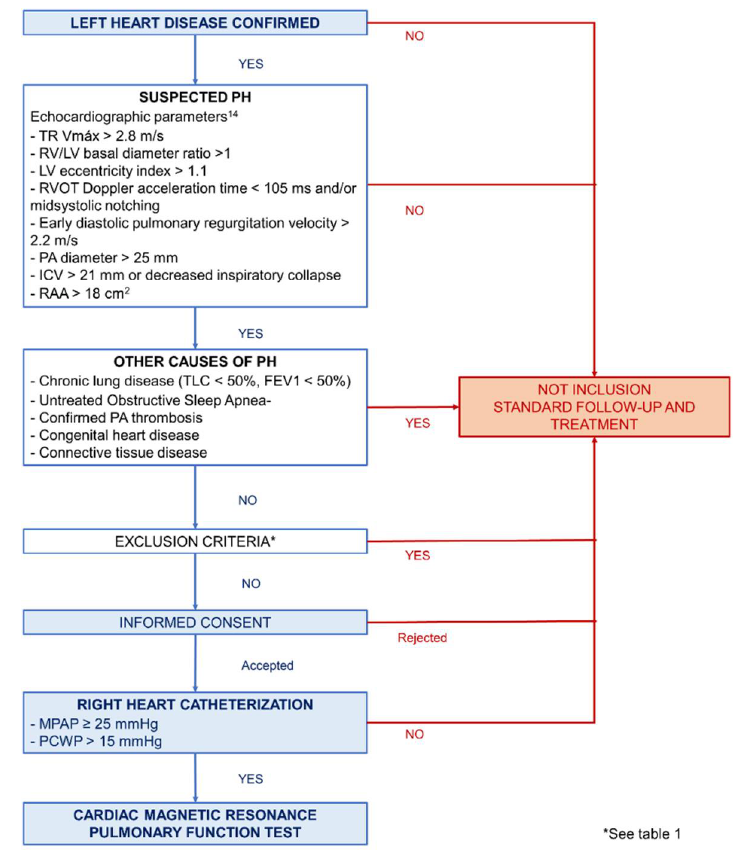
Figure 2. Patients’ selection and study organization. Patients with symptomatic HF will be considered for the study if they have been diagnosed with left heart disease with an echocardiographic suspicion of PH, not explained by other causes. Those patients meeting all inclusion criteria and no exclusion criteria (see Table 1) who have PH confirmed by RHC will be submitted to magnetic resonance imaging and a pulmonary function test. ICV: inferior cava vein; LV: left ventricle; MPAP: mean pulmonary artery pressure; PA: pulmonary artery; PCWP: pulmonary capillary wedge pressure; PH: pulmonary hypertension; RAA: right atrial area; RV: right ventricle; RVOT: right ventricle outflow tract; TLC: total lung capacity; FEV1: forced expiratory volume in first second; TR: tricuspid regurgitation.